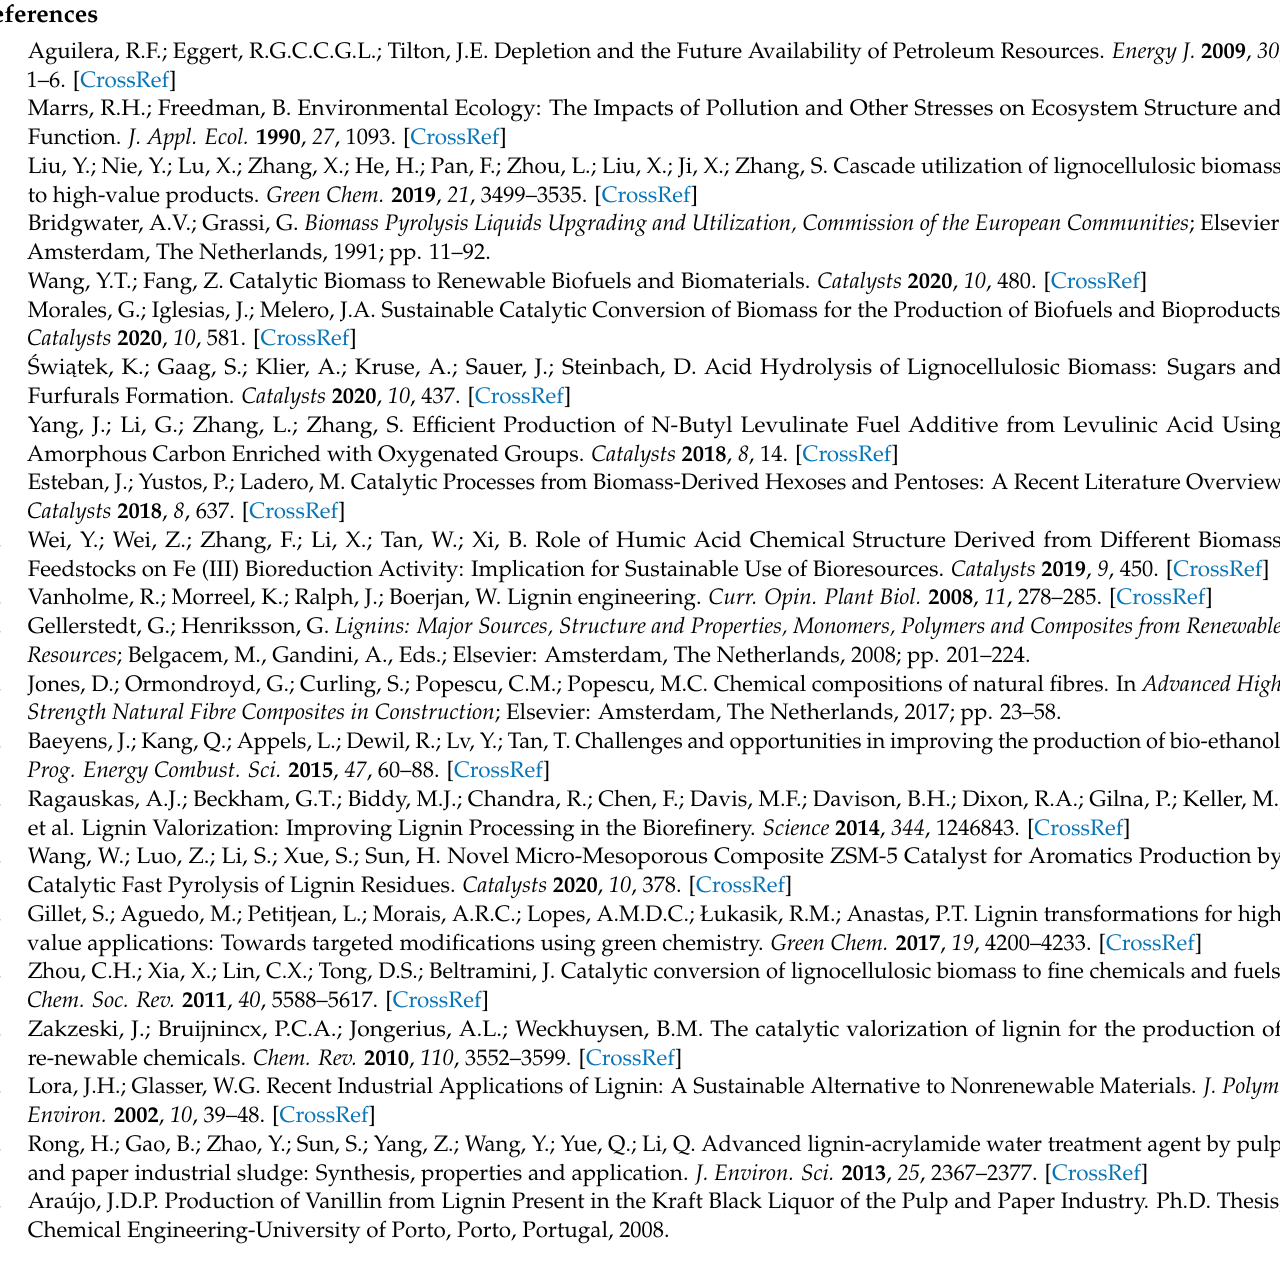
Figure 2. H 2 -TPR profiles of 5 wt.% (a) Ni 2 P/ ɣ -Al 2 O 3 , (b) CoP/ ɣ -Al 2 O 3 , and (c) Fe 2 P/ ɣ -Al 2 O 3 supported